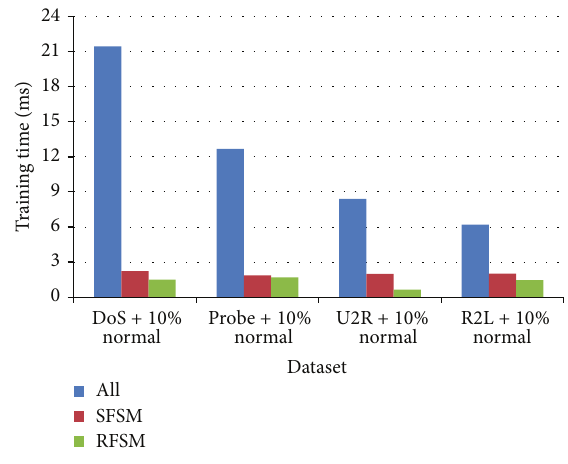
Figure 12: Training time of